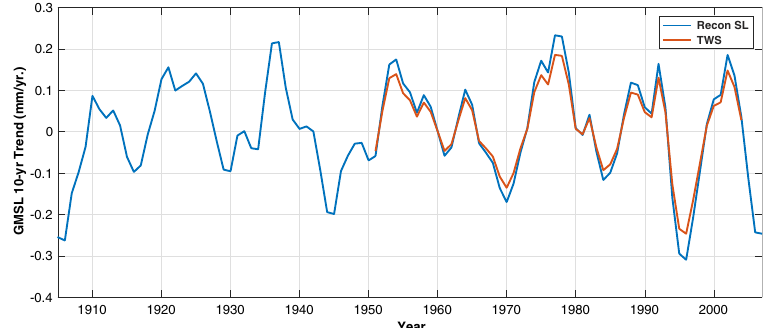
Figure 2. Contribution of the EOF modes shown in Fig. 1 to the 10-year trends in GMSL. The TWS is estimated from the EOF projection onto the GLDAS-2 data (Fig. 1b). Note, the sign of the contribution from the GLDAS-2 EOF has been reversed to reflect the contribution to GMSL and not the contribution to TWS.